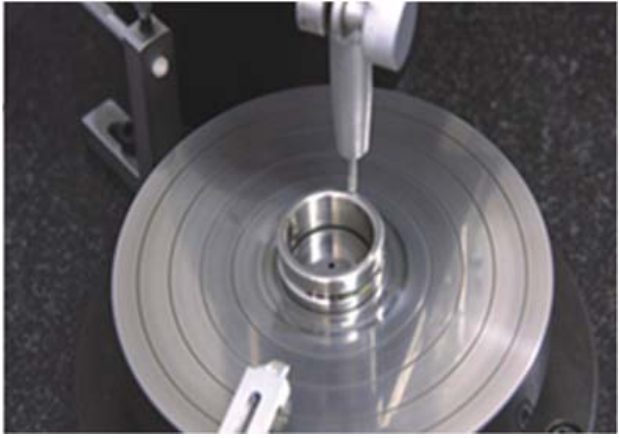
Figure 13. Bearing raceway accuracy test.